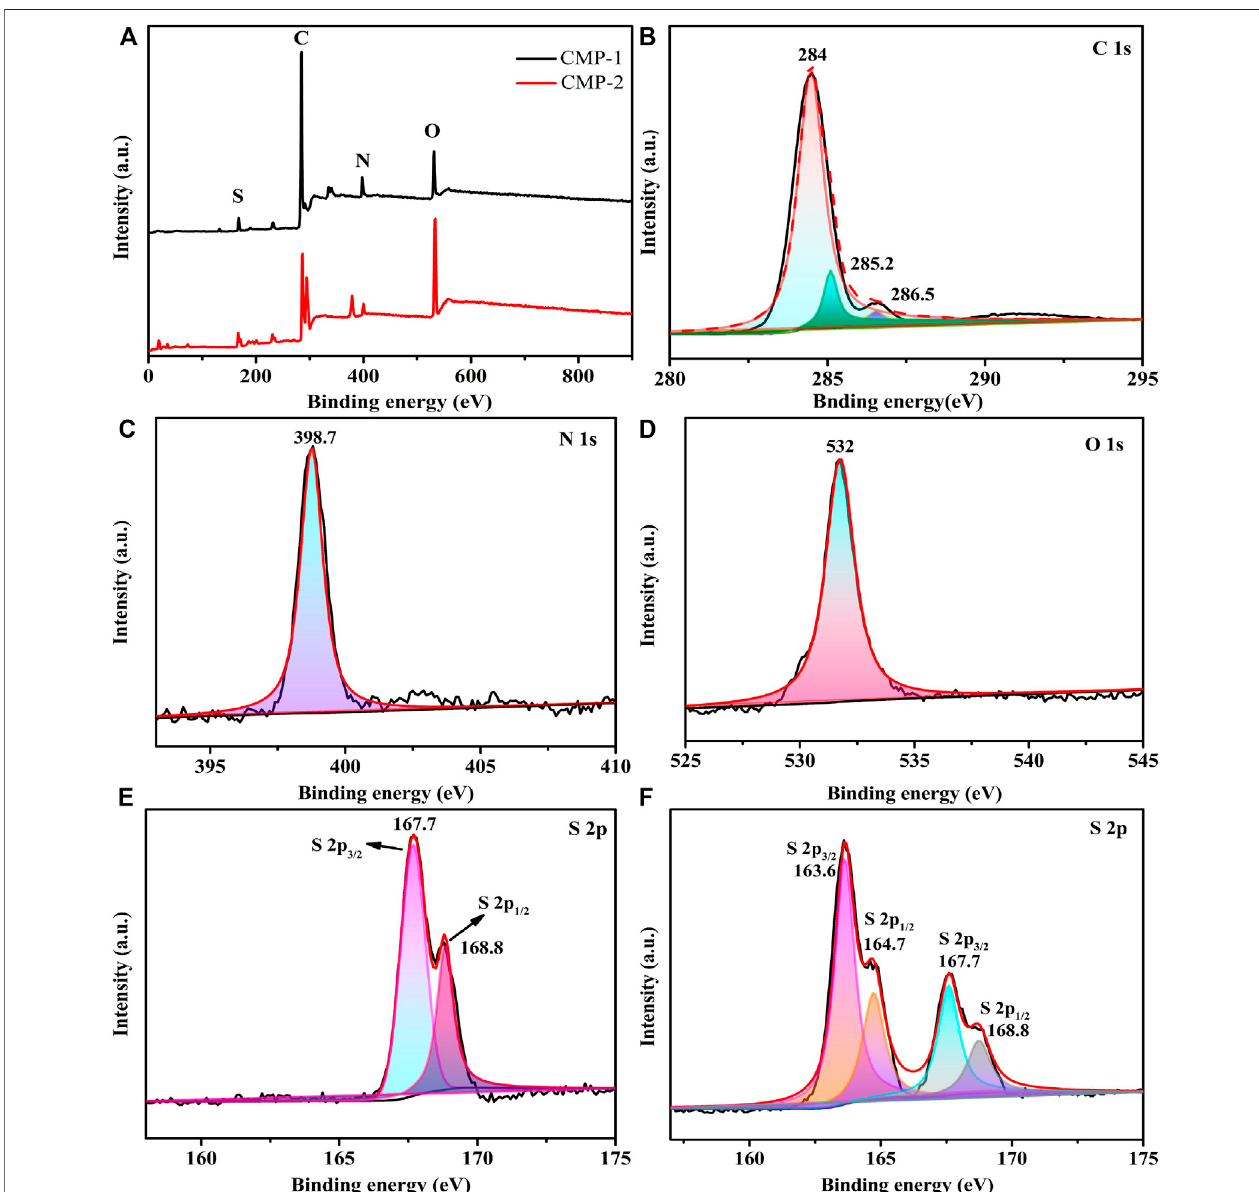
FIGURE 3 | XPS survey spectrum (A) ; high resolution XPS spectra of C 1s region (B) , N 1s region (C) , O 1s region (D) , and S 2p region of CMP-1 (E) ; and high resolution XPS spectra of S 2p region of CMP-2 (F) .